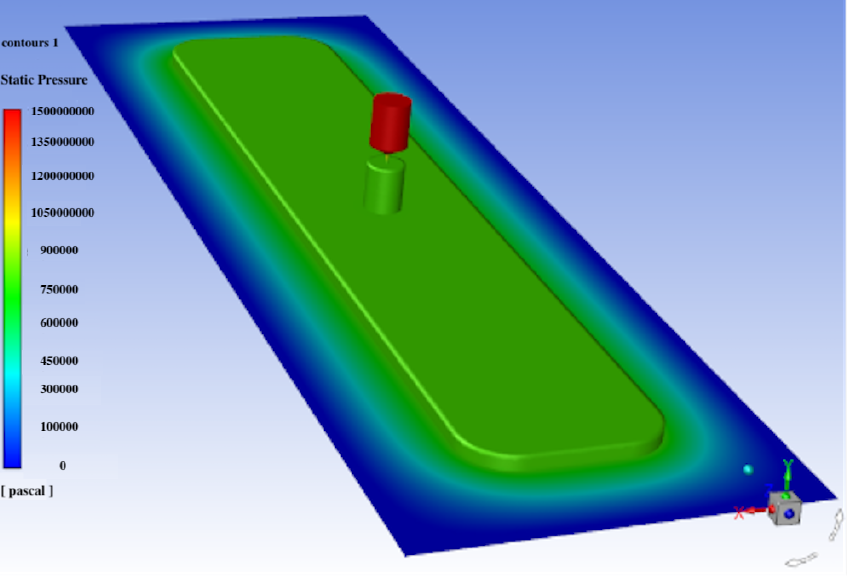
Figure 12. Pressure profile of simplified model (film thickness h = 25 µ